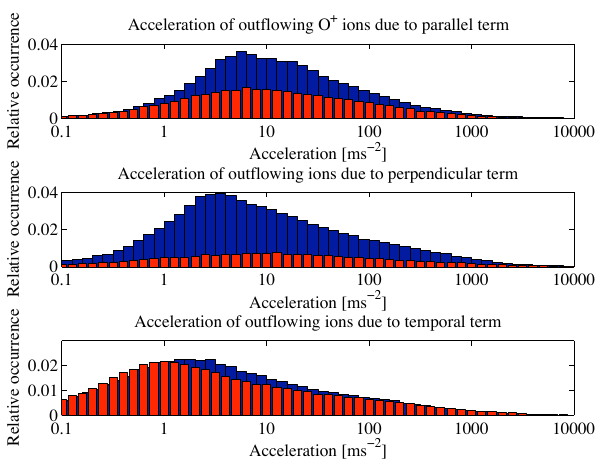
Fig. 2. Distribution of the centrifugal acceleration for all measurement points in the statistical study where the H + density was above 0.1 cm − 3 . The x-axis shows the acceleration [ ms − 2 ] , the y-axis shows the relative occurrence for positive (increased outflow velocity, blue bars) and negative acceleration (decreased outflow velocity, red bars). The red bars are shifted half a bin towards lower values to increase readability. The upper panel shows the parallel term, the middle panel the perpendicular term and the third panel the temporal term of equation 1.